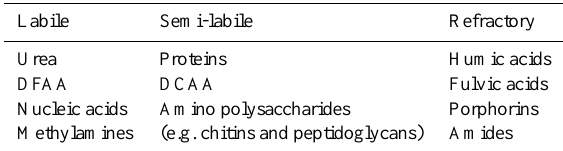
Table 1. Labile, semi-labile and refractory components of the DON